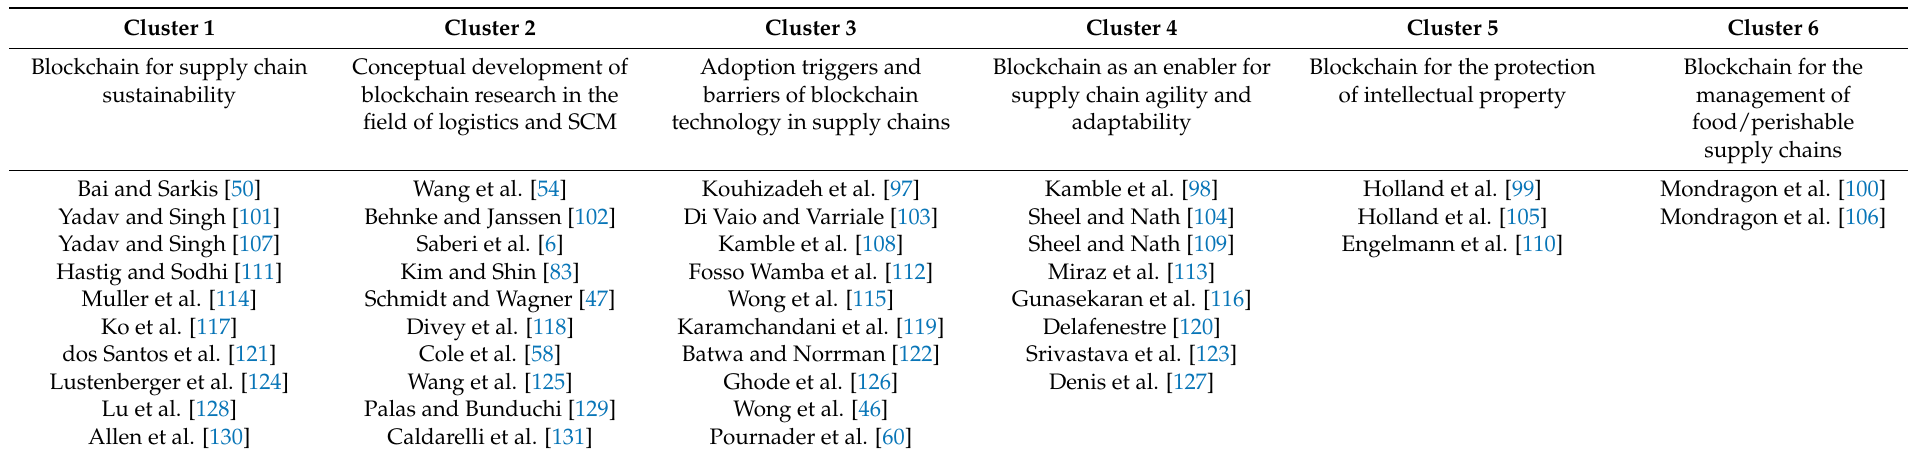
Table 8. Lead papers from each cluster according to their